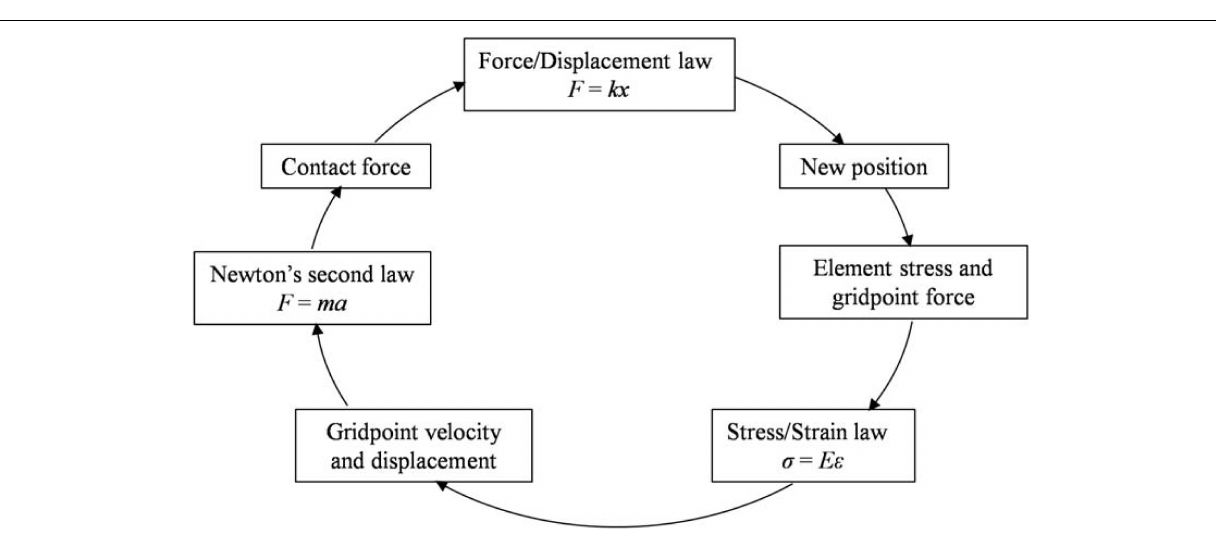
FIGURE 4 | The geological longitudinal profile of the Xinmo landslide along a typical cross section (Section A’-A in Figure 1B ).